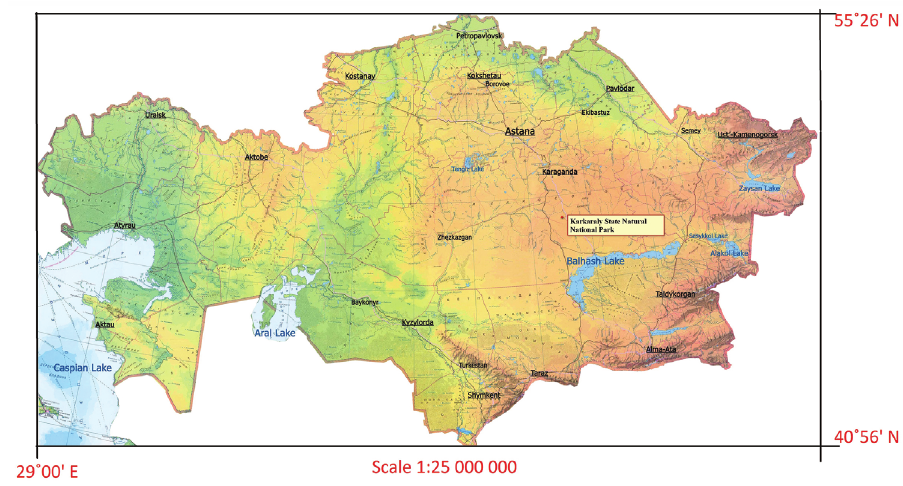
Figure 4. The research region in the Republic of